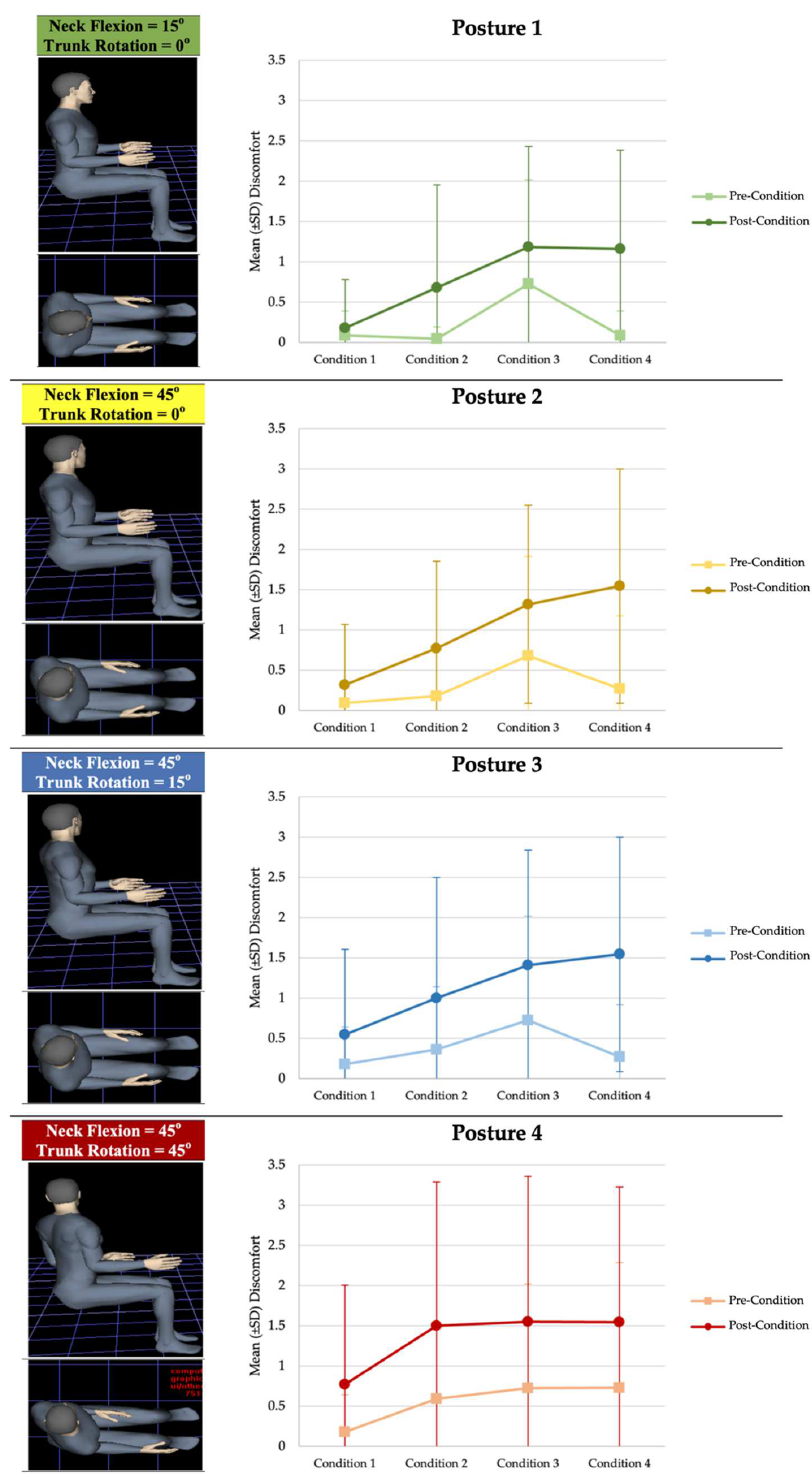
Figure 7. Mean (±SD) self-reported discomfort scores (0–9) in each posture for 11 participants pre- and post-exposure conditions (combinations of rotation and vibration).